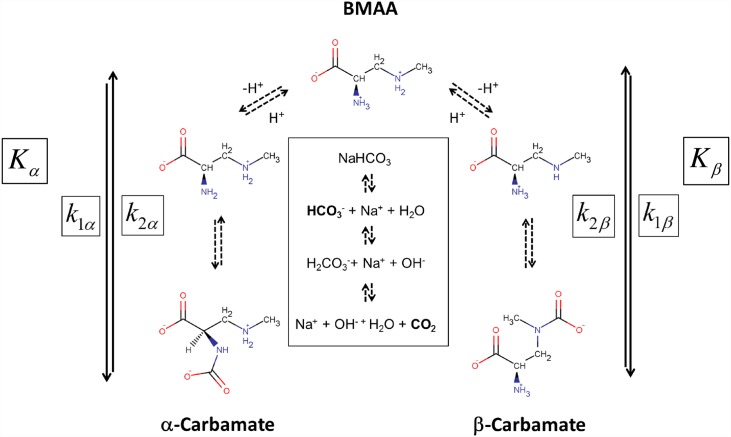
Kinetic equilibrium process of the conversion and chemical exchange of β-Methylamino-L-alanine (BMAA) with α-carbamate and β-carbamate upon interaction with sodium bicarbonate.At neutral pH both the α- and β- carbamate adducts coexist in solution and undergo detectable chemical exchange with the free BMAA. The exchange rates between the free BMAA and that of the α-carbamate and β-carbamates are defined as k1α (reverse rate k2α) and k1β (reverse rate k2β), with the chemical equilibrium constants of Kα and Kβ, respectively. Two-dimensional saturation transfer exchange spectroscopy (EXSY) is used to characterize the chemical exchange mechanism and equilibrium constants. Figure also shows the other reactions that are responsible for generating the bicarbonate ion and CO2 under aqueous conditions (middle part) and are shown in block letters. The two-way arrows with continuous lines (i.e., ⇄) to represent equilibria with kinetically measurable rate constants, while arrows with the dashed lines represent equilibrium processes that are faster than the NMR measured chemical exchange parameters.